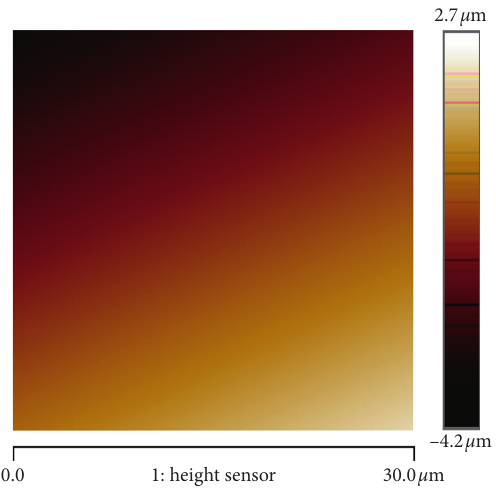
Figure 9: DMT modulus diagram of matrix